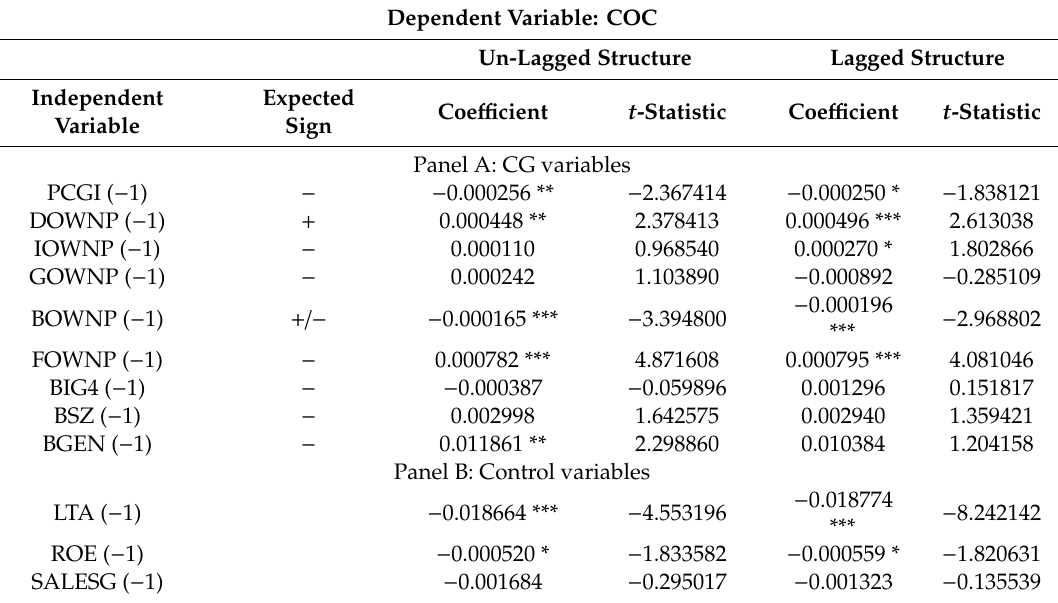
Table 6. Results based on lagged